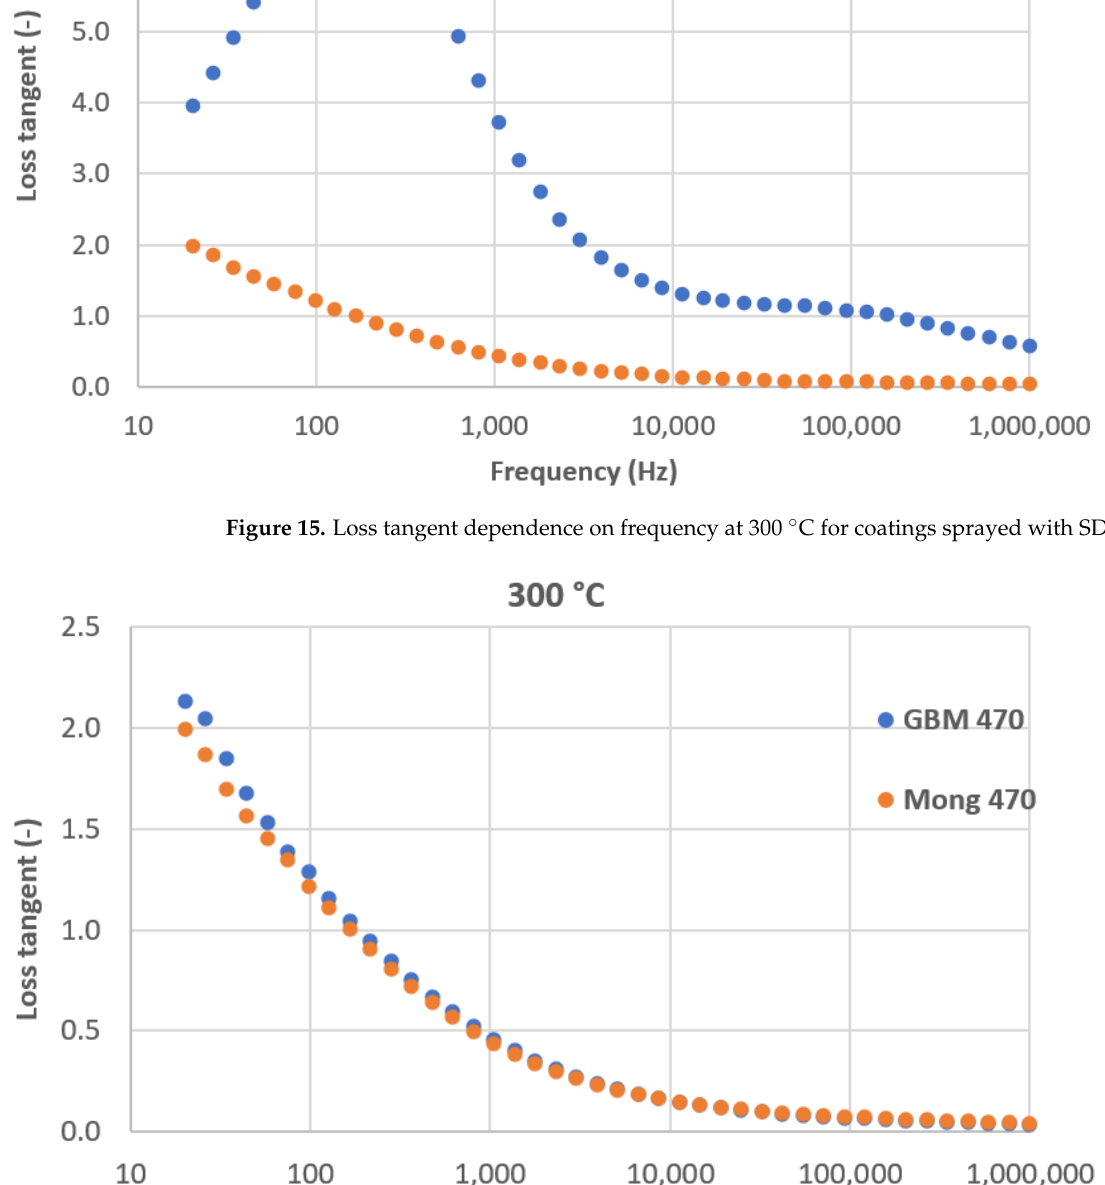
Figure 16. Loss tangent dependence on frequency at 300 °C for coatings sprayed with SD 470. The volume DC resistivity, Figure 17, of the Mong garnet coating was markedly higher, whereas the short SD meant higher resistivity than long SD. The combination of stable permittivity and low loss tangent meant the coating of Mong 370 was the best one. The Mong coating showing a crystalline phase, Table 1, i.e., Fe 3 (Al 1.7 Fe 0.3 )(SiO 4 ) 3 , was of a near-almandine composition (pure almandine is 3FeO · Al 2 O 3 · 3SiO 2